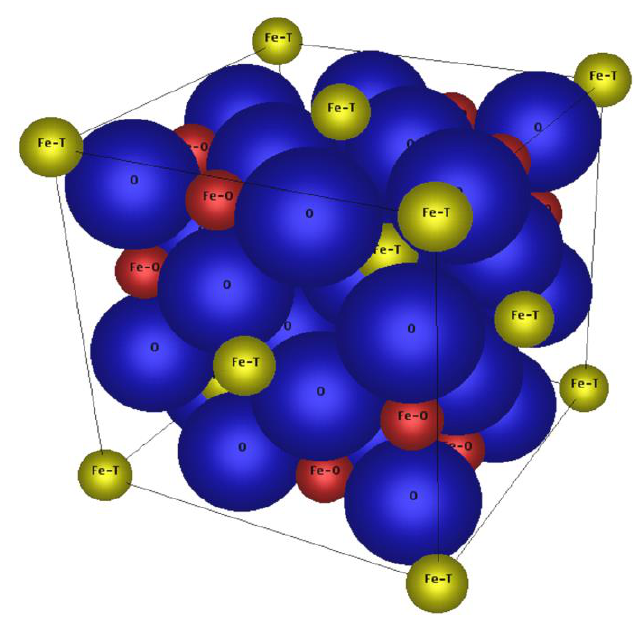
Figure 1. Unit cell of the spinel lattice of magnetite, consisting of 32 O 2 − ions (O), 8 Fe 2 + and 8 Fe 3 + ions on the octahedral sites (Fe–O) as well as 8 Fe 3 + ions on the tetrahedral sites (Fe–T); created with CrystalDesigner ® .